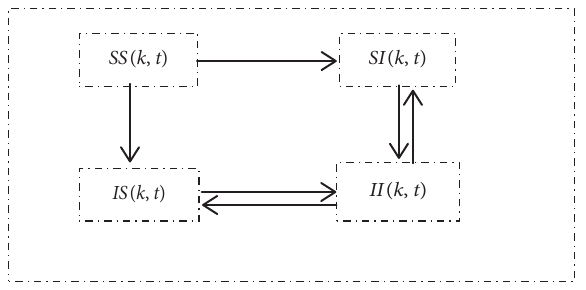
Figure 1: Dynamic process of dual product information